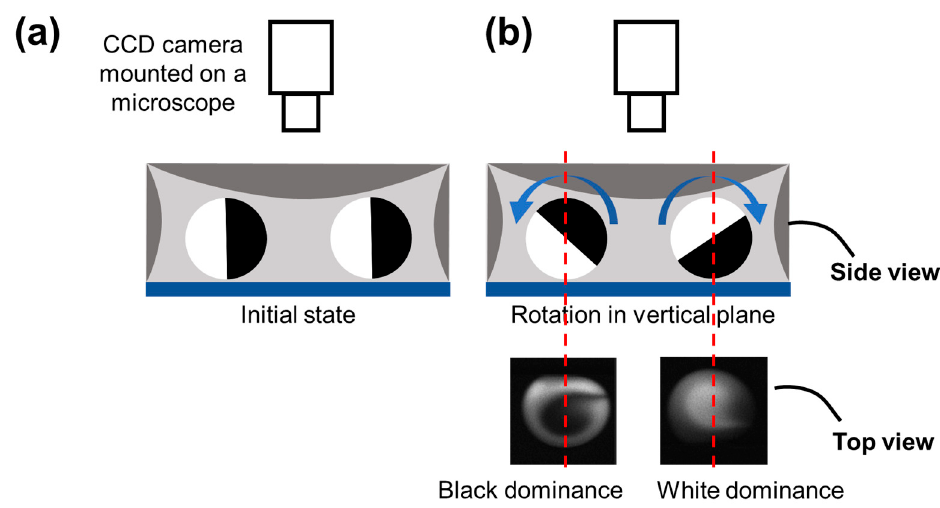
Figure 3. Schematics of droplet rotation. ( a ) The black and white areas were balanced when there is no rotation behavior in the vertical plane. ( b ) There would be one color covering the central region from the top view when there exists rotation behavior in the vertical plane.